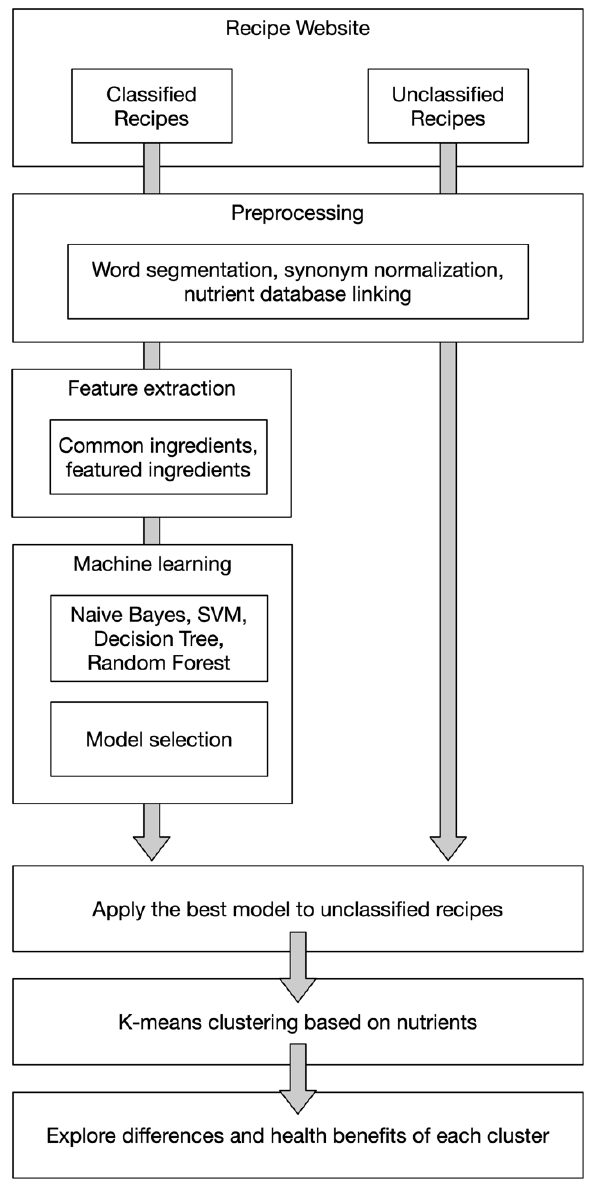
Figure 2. Linkage of online recipes and nutritional database to include rich nutrition Figure 1. Framework of our analysis system. Figure 1. Framework of our analysis system.